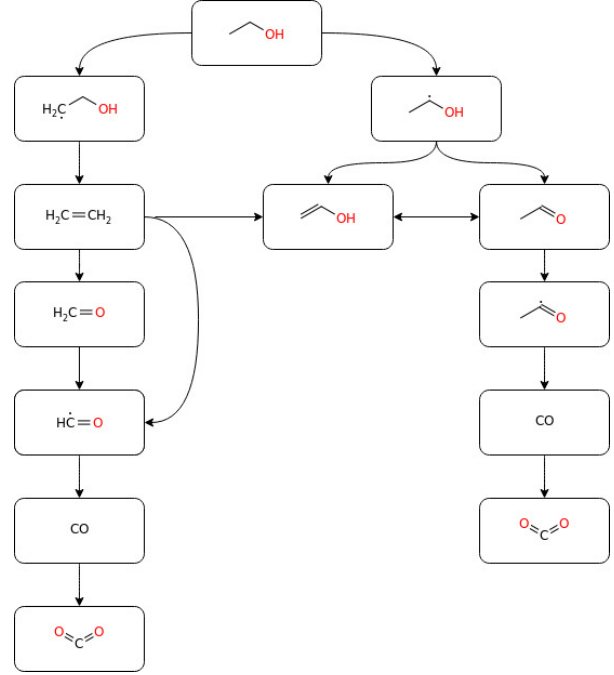
Figure 3. Simplified representation of the reaction paths of ethanol in air. As can be seen from the figure, sC 2 H 4 OH (C[CH]O in SMILES notation) was the main primary intermediate from ethanol decomposition through hydrogen abstraction by HO 2